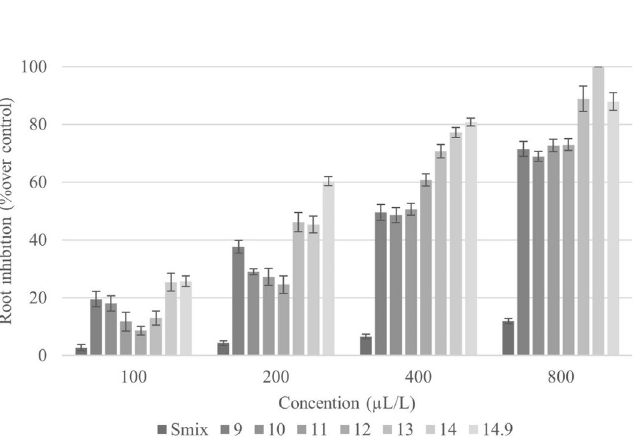
Figure 6. Inhibitory effect of CEO nanoemulsions with different HLB values on root length of E. crus-galli . Error bars represent standard deviation of the